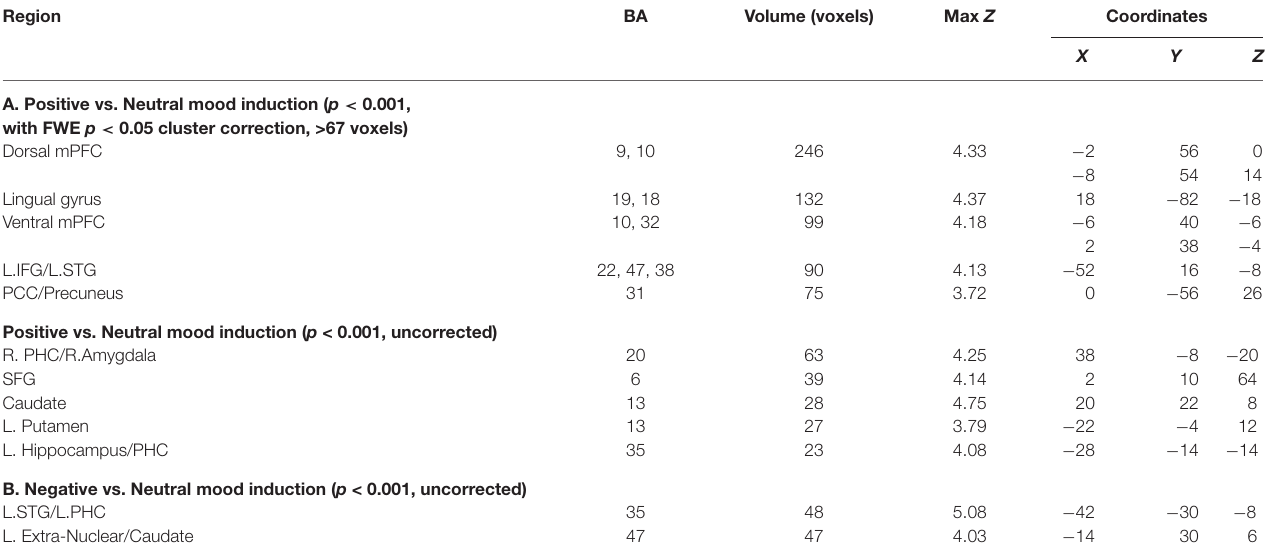
TABLE 3 | Positive vs. Neutral MIs and Negative vs. Neutral MIs.